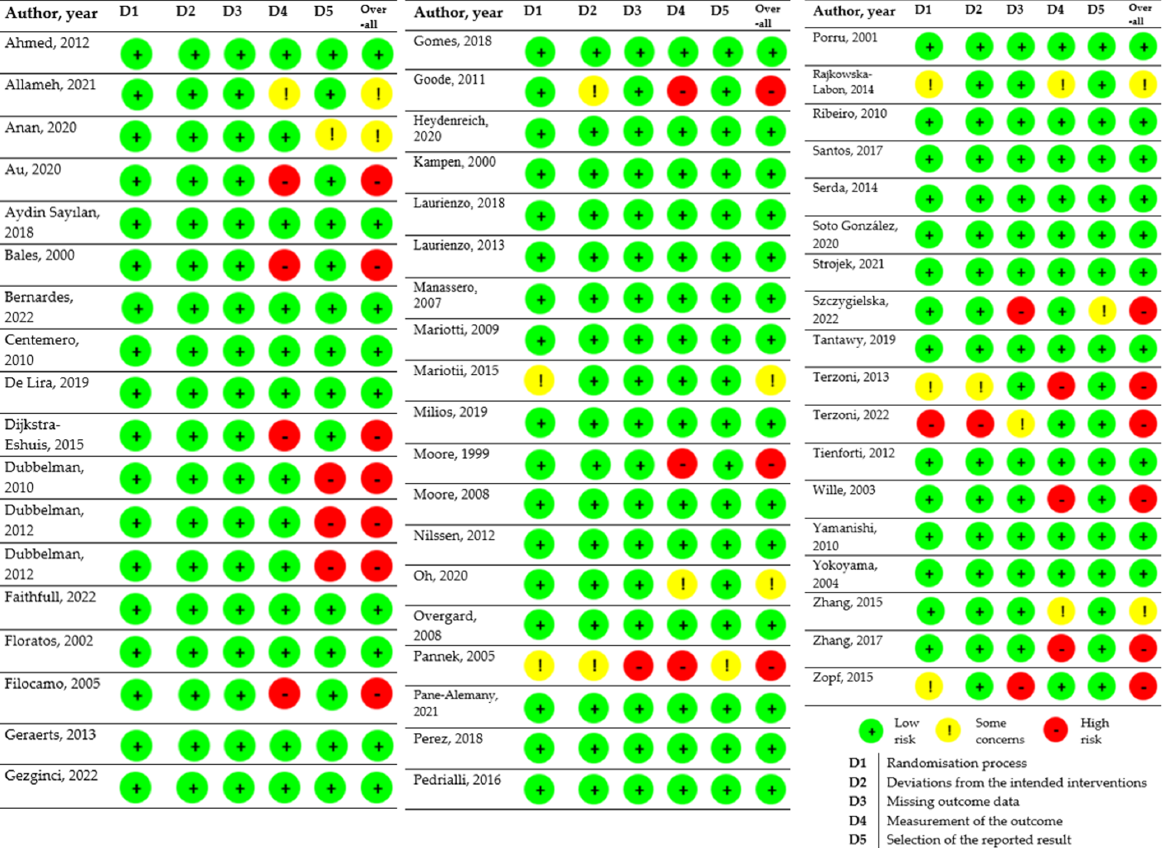
Figure A2. Summary plot of the overall risk of bias ( n = 55).